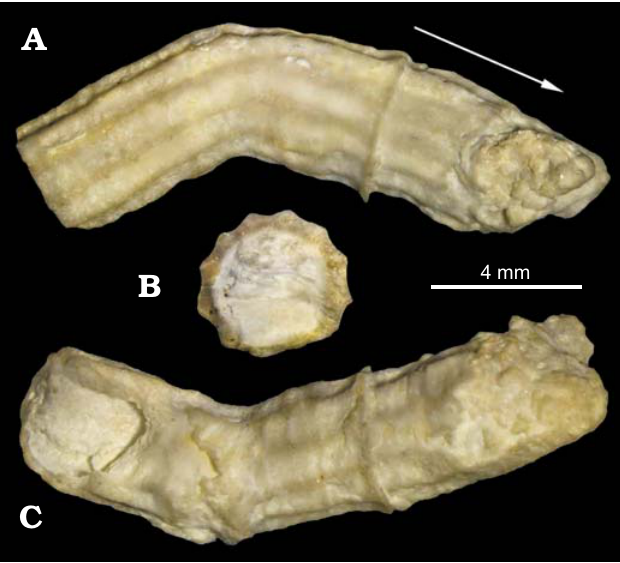
Fig. 3. The alleged serpulid Palaeotubus sosiensis gen. et sp. nov., holo- type (MSNC 4499) from Pietra di Salomone limestone, Palazzo Adriano (Sicani Mountains, W Sicily); Wordian to upper Permian. The specimen was accurately cleaned from the rock but the white limestone is still visible infilling the tube lumen. Two opposite side views ( A , C ), growth direction arrowed, cross section ( B